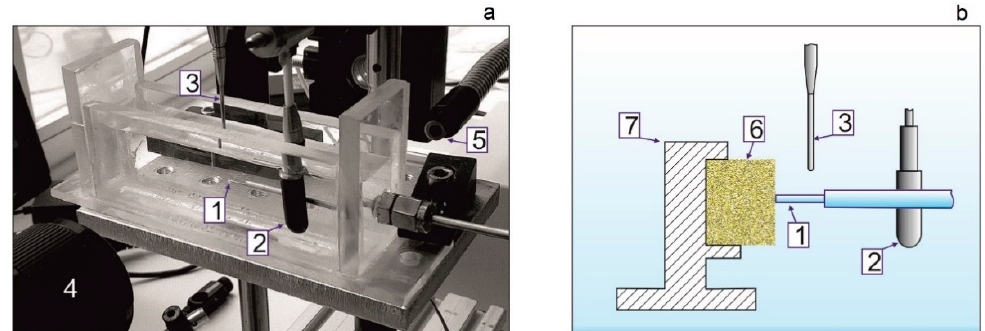
Figure 2. Fragment of experimental laser-induced hydrodynamic processes near the fiber end ( a ) and the layout of the configuration of the elements under the phantom laser exposure ( b ). 1—fiber end (tip), 2—wide-band hydrophone 8103, 3—needle hydrophone, 4—high-speed camera lens Fastcam SA-3, 5—frontal light, 6—phantom of the stone, 7—holder.